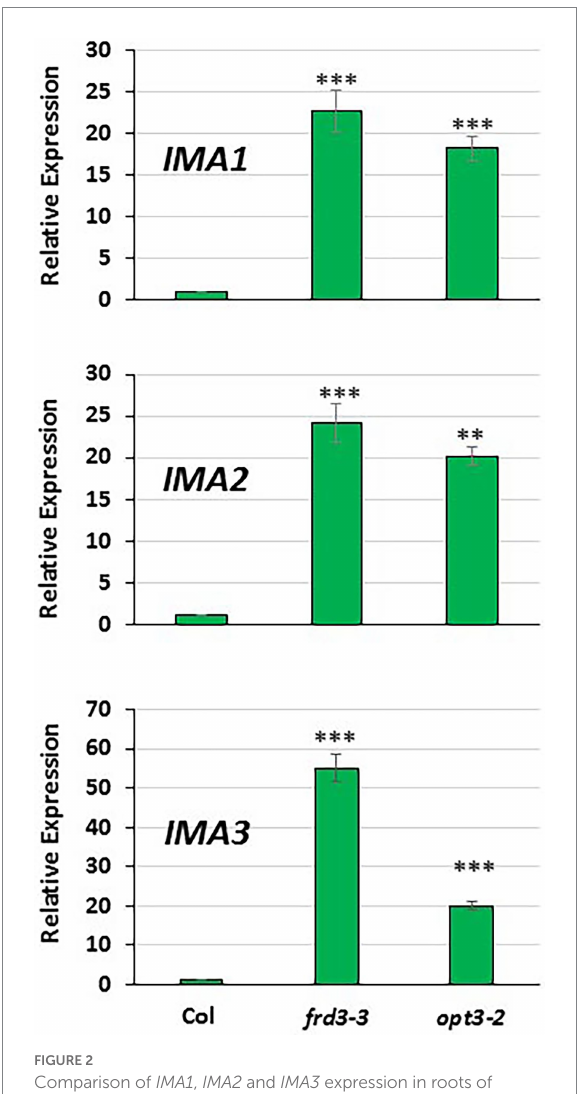
FIGURE 2 Comparison of IMA1 , IMA2 and IMA3 expression in roots of Arabidopsis WT Columbia and its LODIS defective mutants frd3-3 and opt3-2 grown under Fe-sufficient conditions. Plants were grown in complete nutrient solution. When appropriate, were transferred to complete nutrient solution with 40 μ M Fe-EDDHA (+Fe40) during 48 h. IMA1 , IMA2 and IMA3 expression was determined by qRT-PCR. Relative expression was calculated in relation to the WT Columbia. Data represent the mean of 3 independent biological replicates ± S.E. Bars with ** or *** indicate significant differences ( p < 0.01 or p < 0.001, respectively) in relation to the WT Colombia +Fe40 treatment according to the Dunnett’s